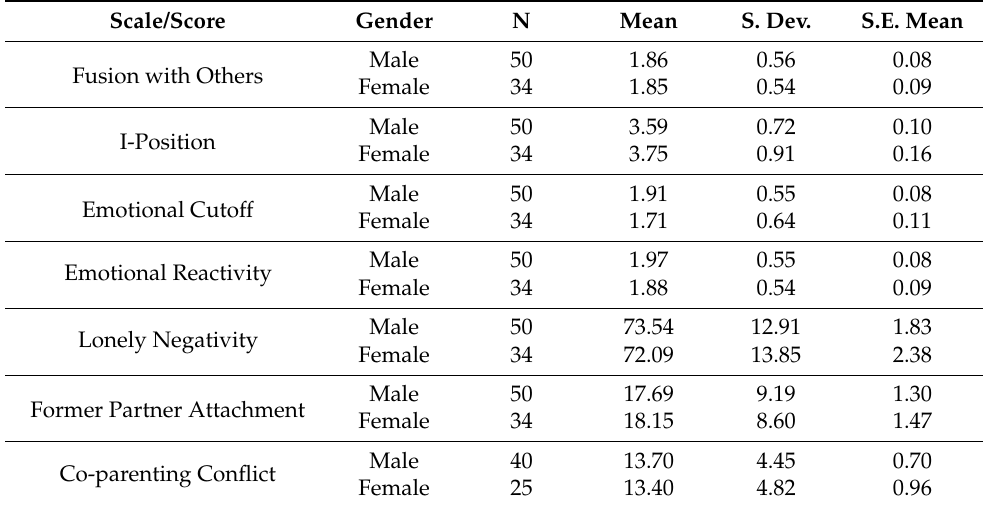
Table 3. Descriptive Statistics by